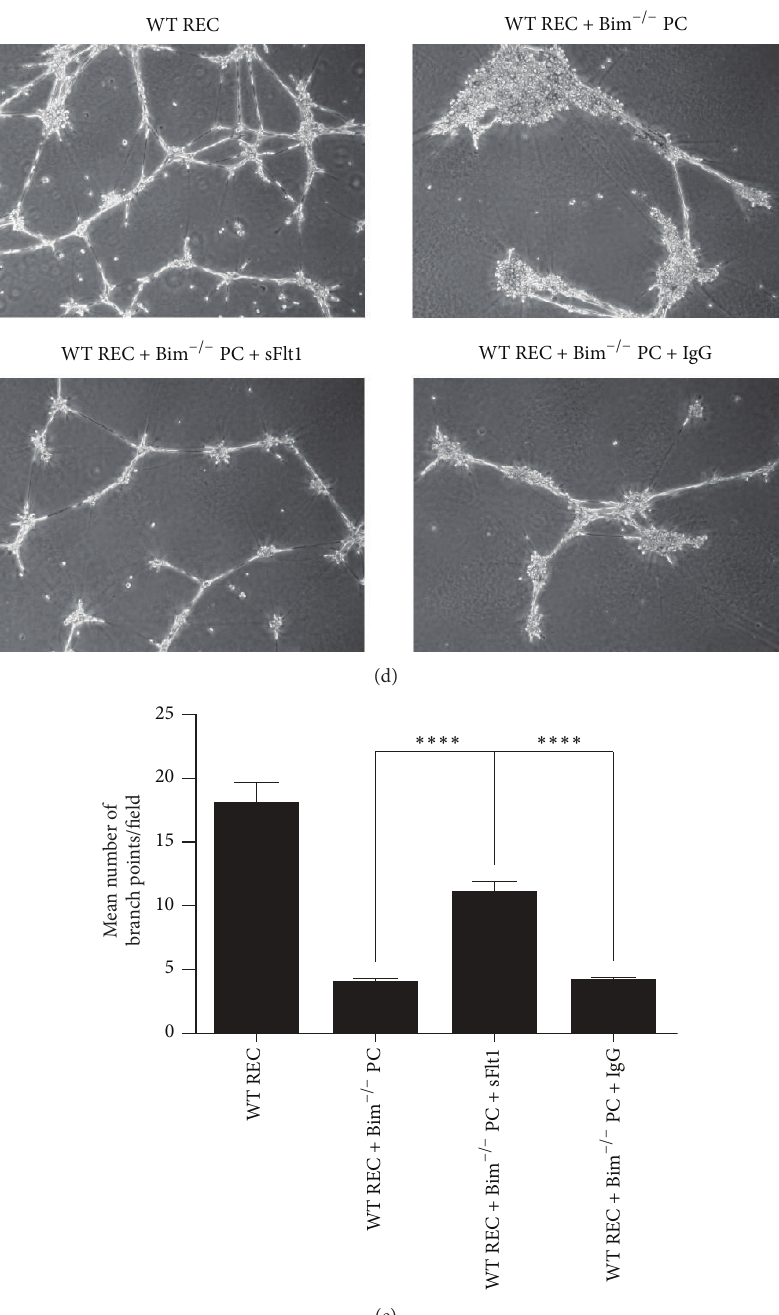
Figure 8: Bim −/− pericytes diminished capillary morphogenesis of retinal endothelial cells. Wild-type (WT) and Bim −/− retinal endothelial cells (REC) were plated alone or with wild-type or Bim −/− pericytes (PC) in Matrigel and photographed in digital format (panel (a)). The quantitative assessment of the data is shown in panels (b) and (c). In panel (d), wild-type retinal endothelial cells were plated alone or with Bim −/− pericytes in the presence or absence of sFlt1 or IgG control (10 𝜇 g/mL) and photographed. Panel (e) is the quantitative assessment of the data in panel (d). The data are the mean number of branch points per field ( × 40) ± SD. These experiments were repeated at least twice with similar results ( ∗∗∗ 𝑃 < 0.001 ; ∗∗∗∗ 𝑃 < 0.0001